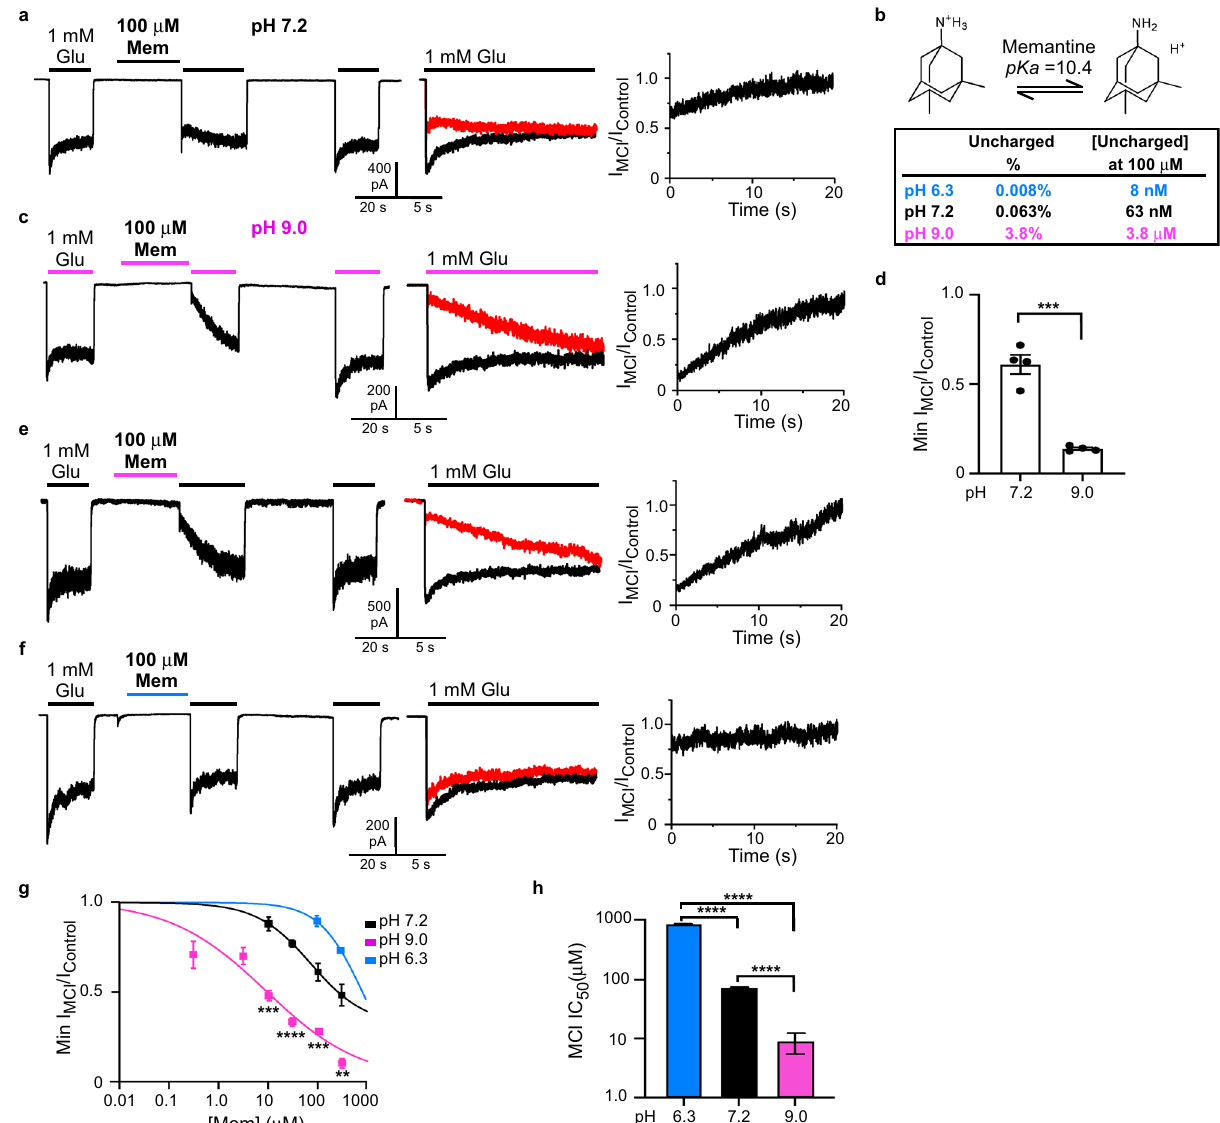
Fig. 1 Memantine MCI is pH-dependent. a MCI protocol at pH 7.2 with 100 μ M memantine (left; Glu = glutamate; Mem = memantine); overlay of I Control and I MCI (middle; I MCI in red); point-by-point ratio, I MCI /I Control (right). Similar current trace formatting is used in following fi gures. b Charged and